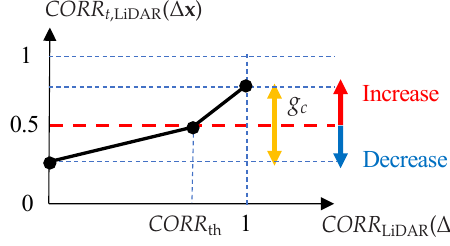
Figure 10. Calculating likelihood from